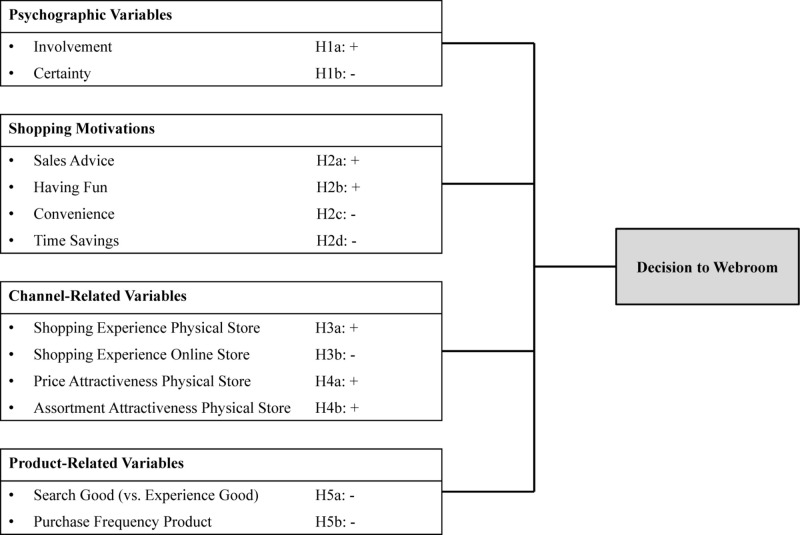
Conceptual model.